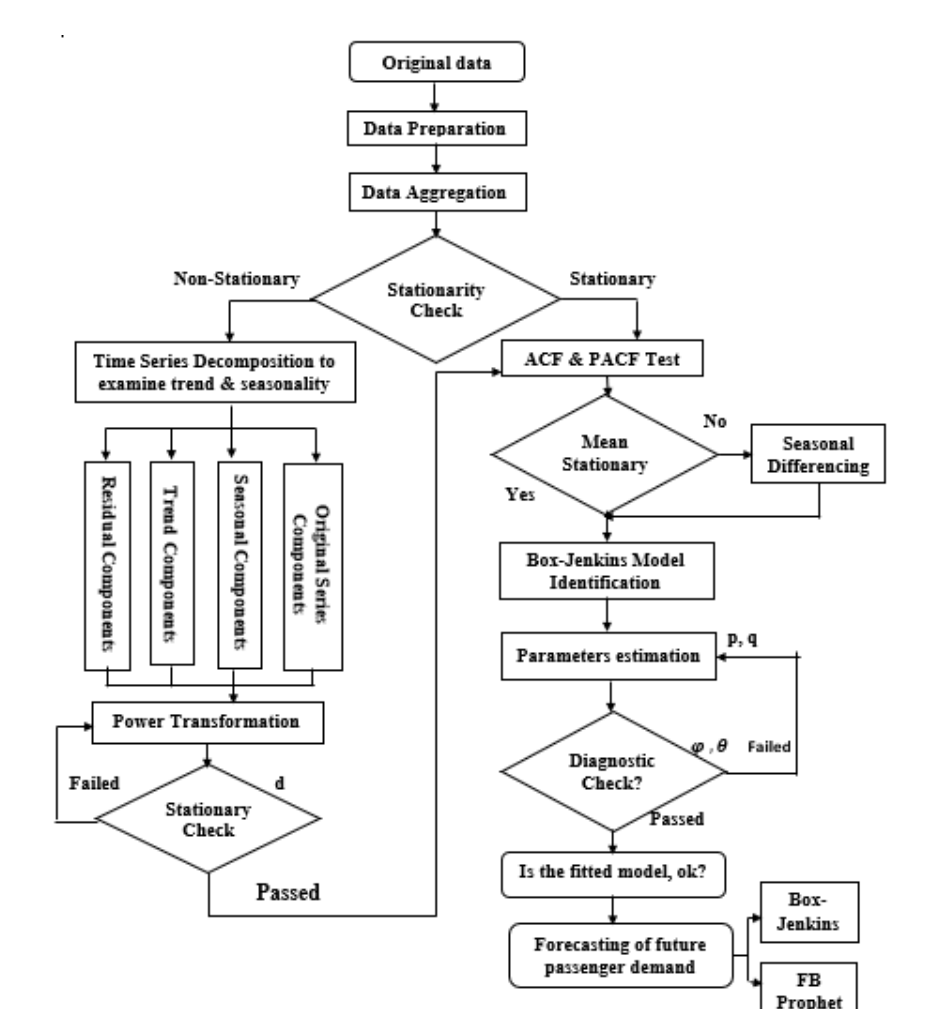
Figure 8. The framework process covered for the construction and selection of the best model.